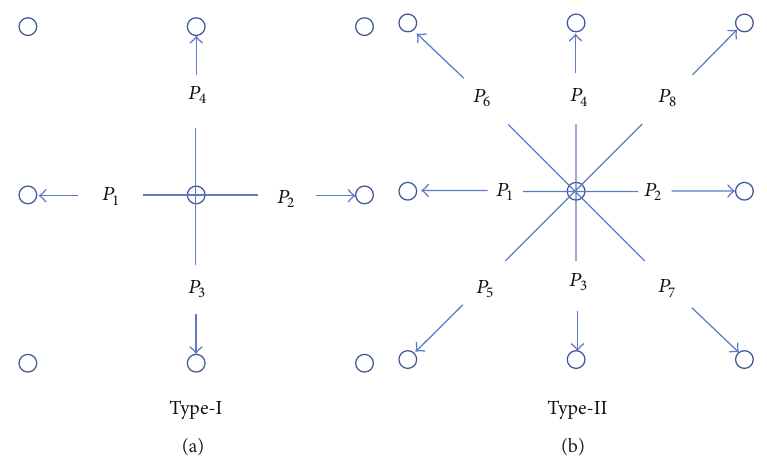
Figure 2: The two types of communicating neighbors of 2D 1-step networks. The nodes pointed by the arrows are the communicating neighbors of the node in the center. The labels on the arrows are probabilities of transmitting to the pointed communicating